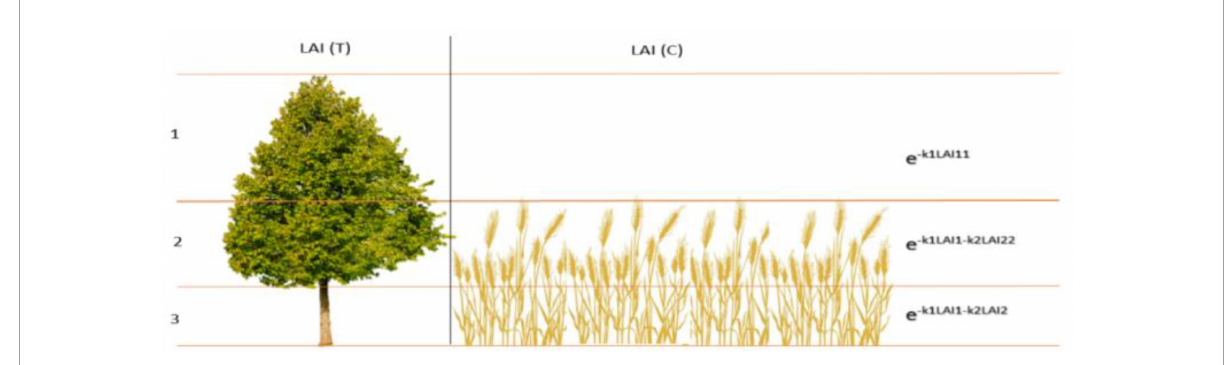
FIGURE4 Schematic diagram of light competition between trees and crops for a simple hypothetical model including the above-ground part and canopy of the tree and the crop is divided into different vertical zones/layers to identify the light competition (a similar pattern is used in the WaNuLCAS